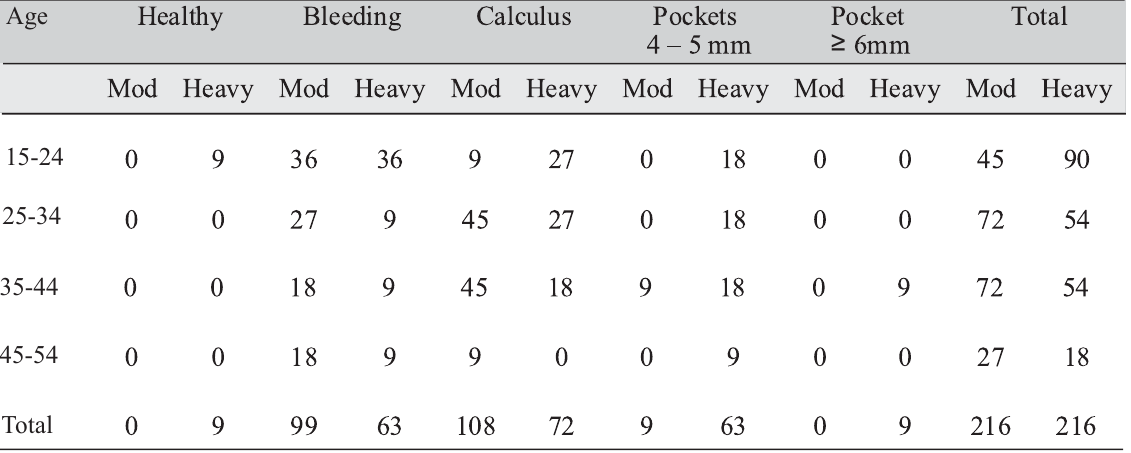
Table 5 - Sample distribution based on frequency of tobacco consumption in accordance with CPI scores in different age groups